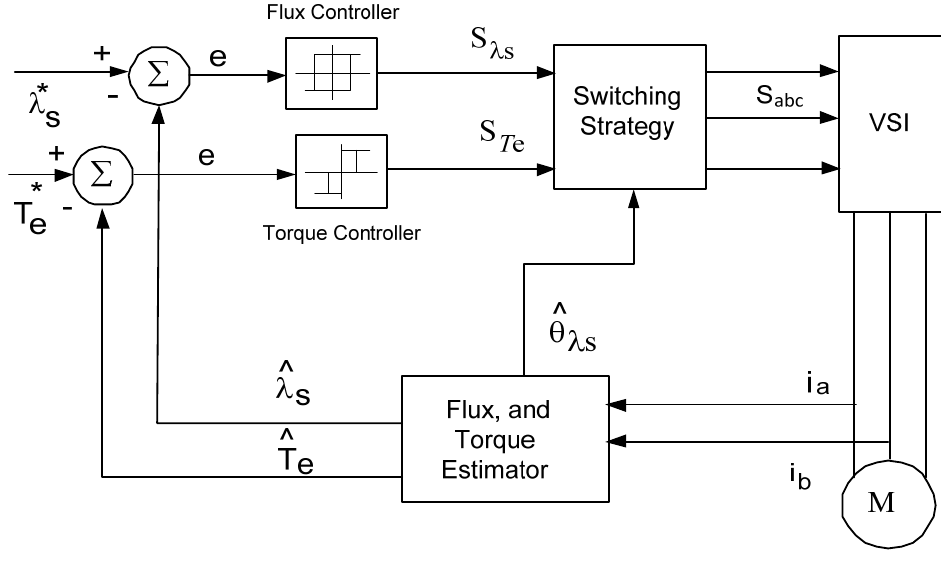
Figure 3. Direct Torque Controlled (DTC) drive